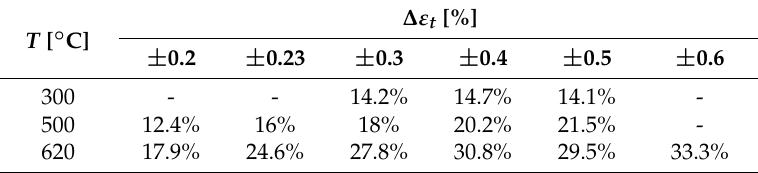
Table 4. Softening ratio as a function of total strain range and temperature for all conducted LCF- tests.